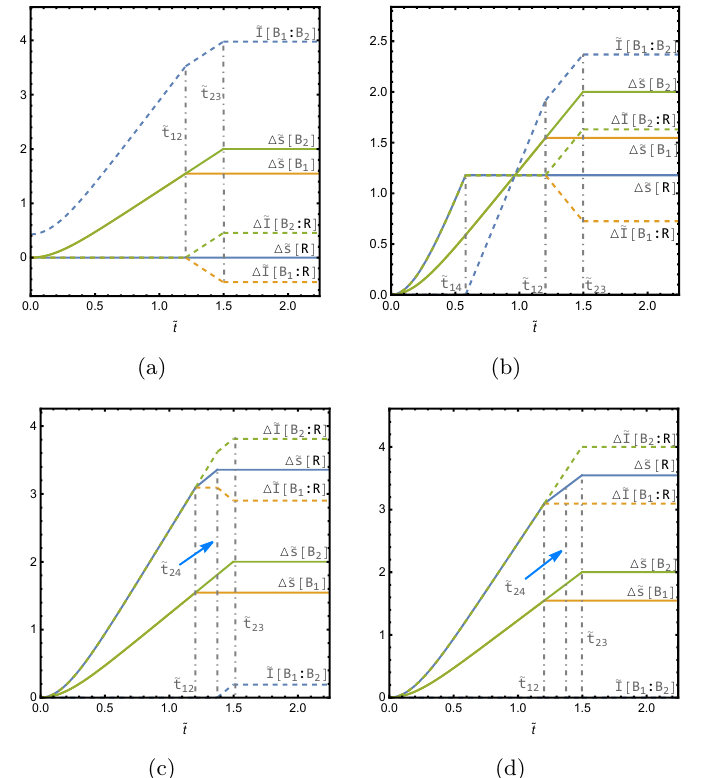
Figure 10 . The evolution on entropy and mutual information density at different distances (a): ˜ w 0 = 8 / 3 , (b): ˜ w = 47 / 15 , (c): ˜ w = 119 / 30 and (d): ˜ w = 20 / 3 , while other parameters being 0 0 0